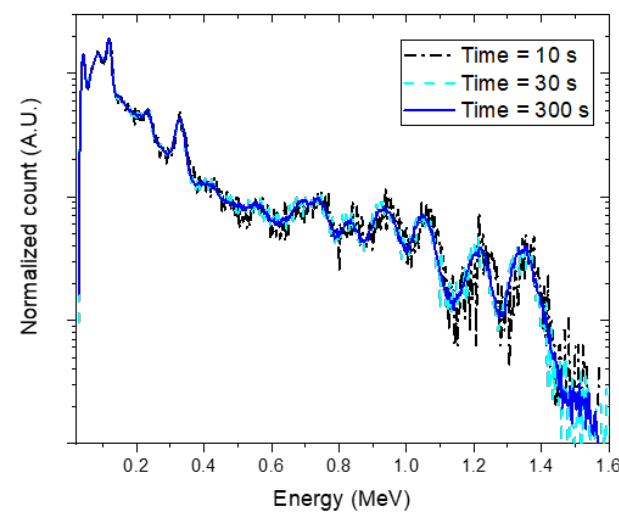
Figure 6. Experimental spectra with different acquisition times of 10 s (black dash-dotted line), 30 s (sky-blue dashed line) and 300 s (blue solid line) for the following radioisotopes buried in sand: Eu-152, 3 cm and Eu-154, 6 cm. Obtained spectra were normalized to the total count over the energies of interest for comparison.